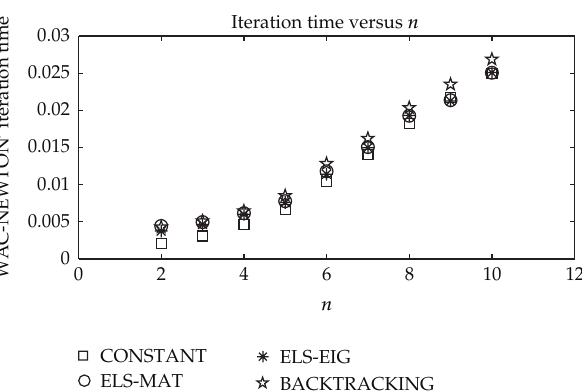
Figure 10: Time required to perform an iteration of SDP-CUT.